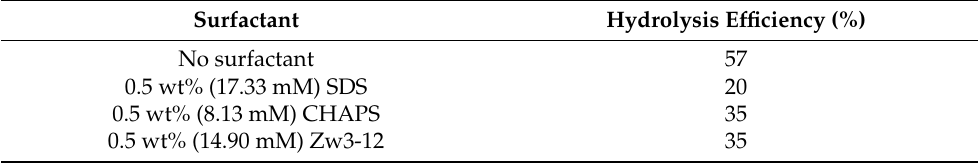
Table 1. The hydrolysis efficiency of OVA hydrolysis by Zr-K 1:2 in the absence or presence